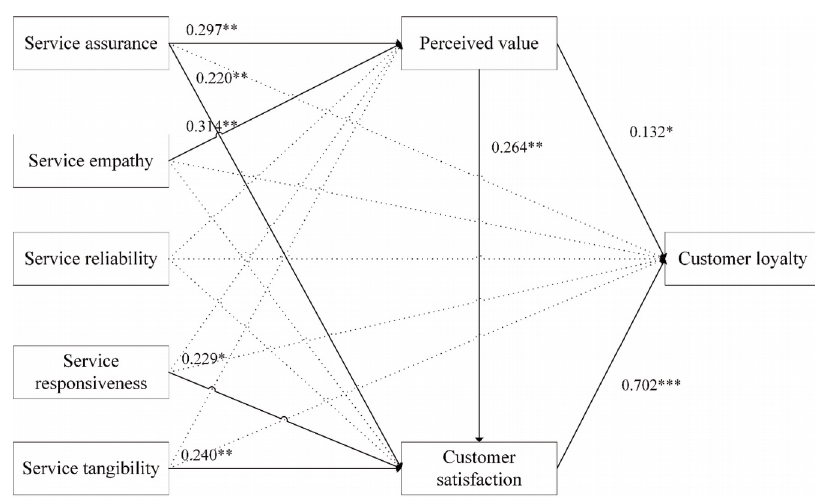
Figure 3. PLS-MGA result of structural equation model for FSC